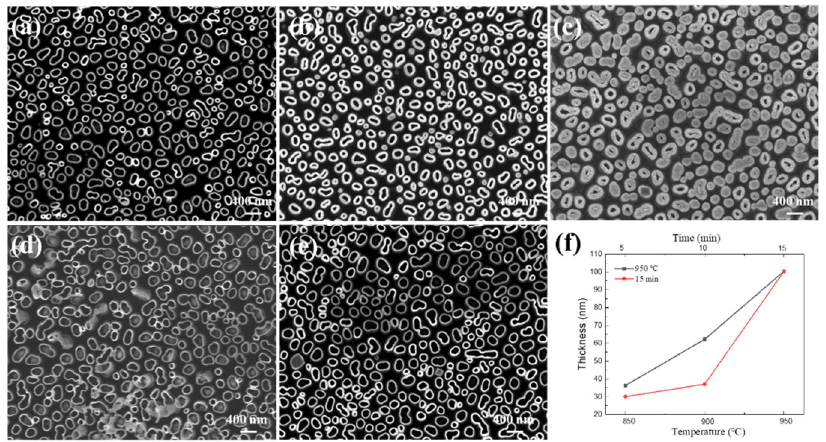
Figure 6. SEM images of the β -Ga 2 O 3 NT arrays prepared in different oxidation times at 950 °C for ( a ) 5 min, ( b ) 10 min, ( c ) 15 min. SEM images of the β -Ga 2 O 3 NT arrays prepared in different oxida- tion temperatures for 15 min at ( d ) 850 °C and ( e ) 900 °C. The oxidation rate images ( f ) of β -Ga 2 O 3 NTs under different oxidation conditions.